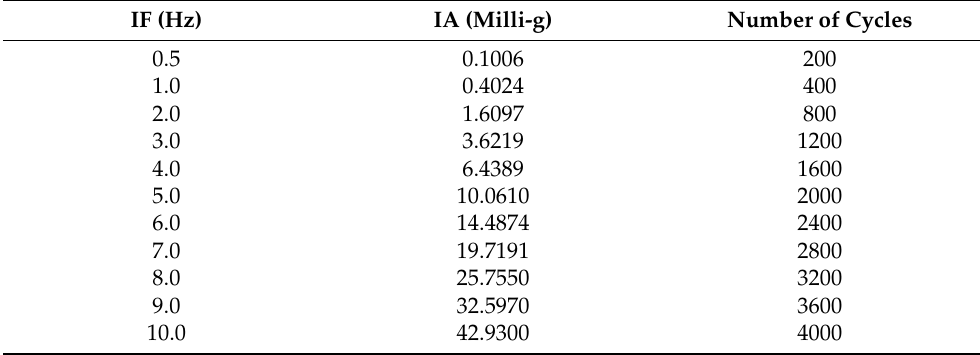
Table 2. Characteristics of introduced